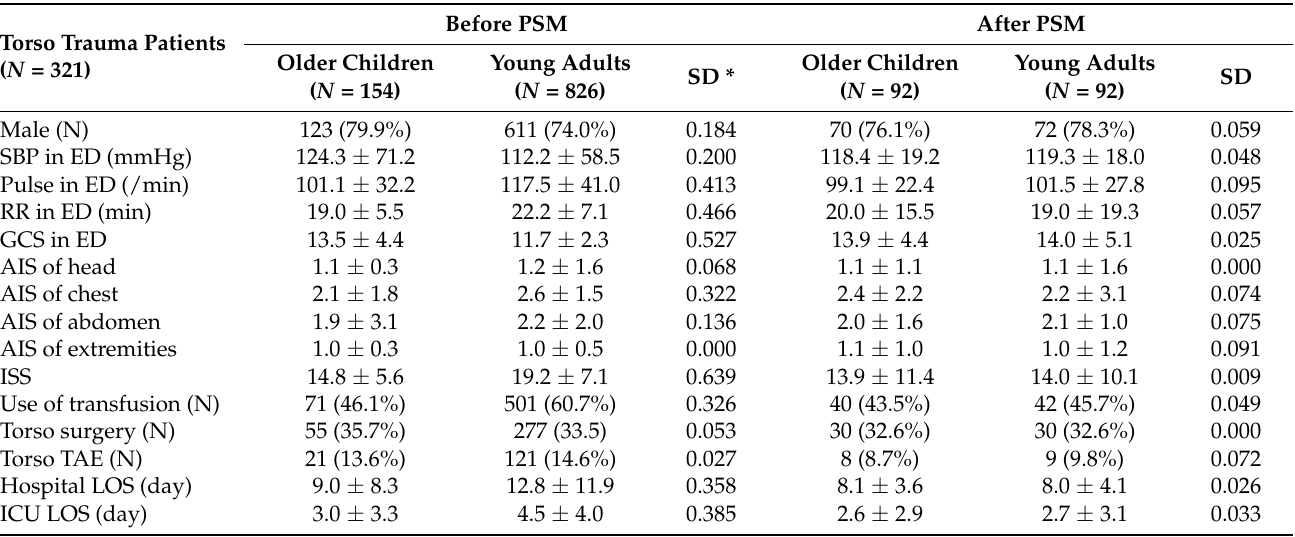
Table 2. Comparisons of demographics, vital signs, injury severities, treatment policies, and outcomes between older children and young adults before and after PSM ( N = 980).